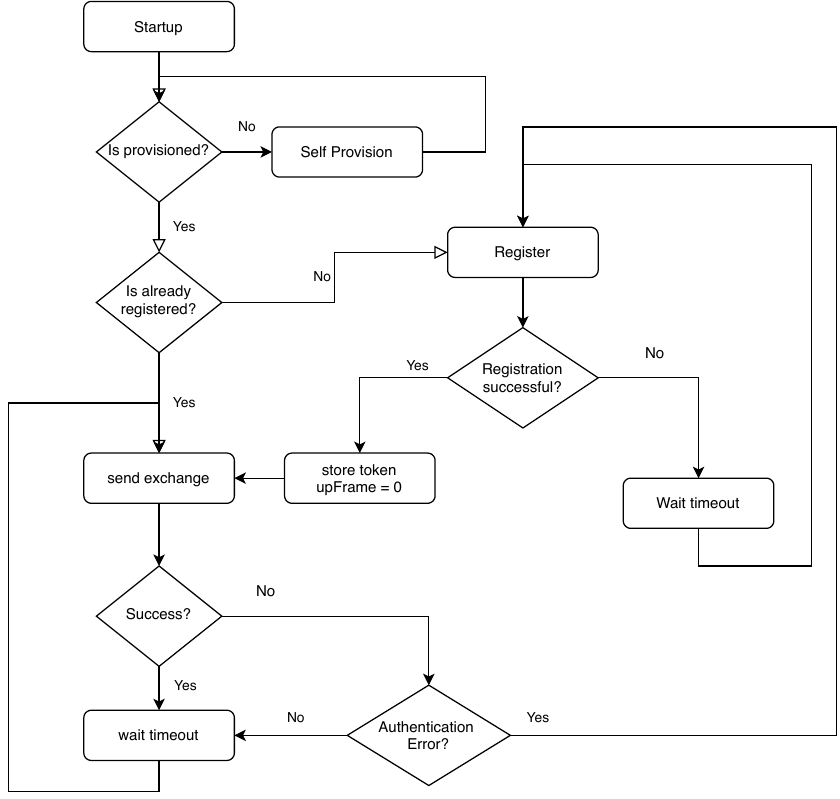
Figure 8. A flowchart showing the connection sequence between the product and the